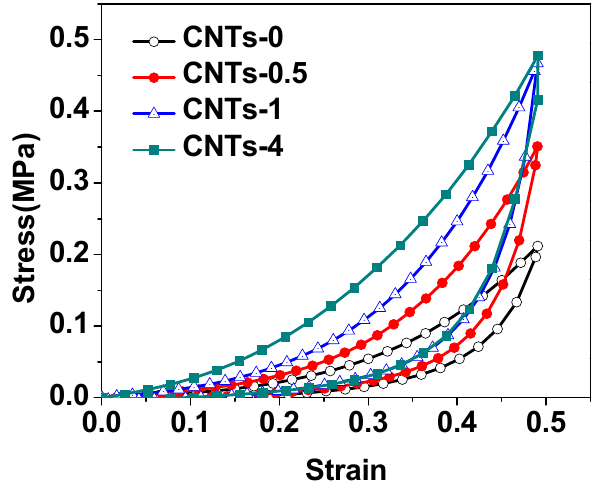
Figure 7. Effect of CNTs contents on the first compressive loading-unloading cycles.